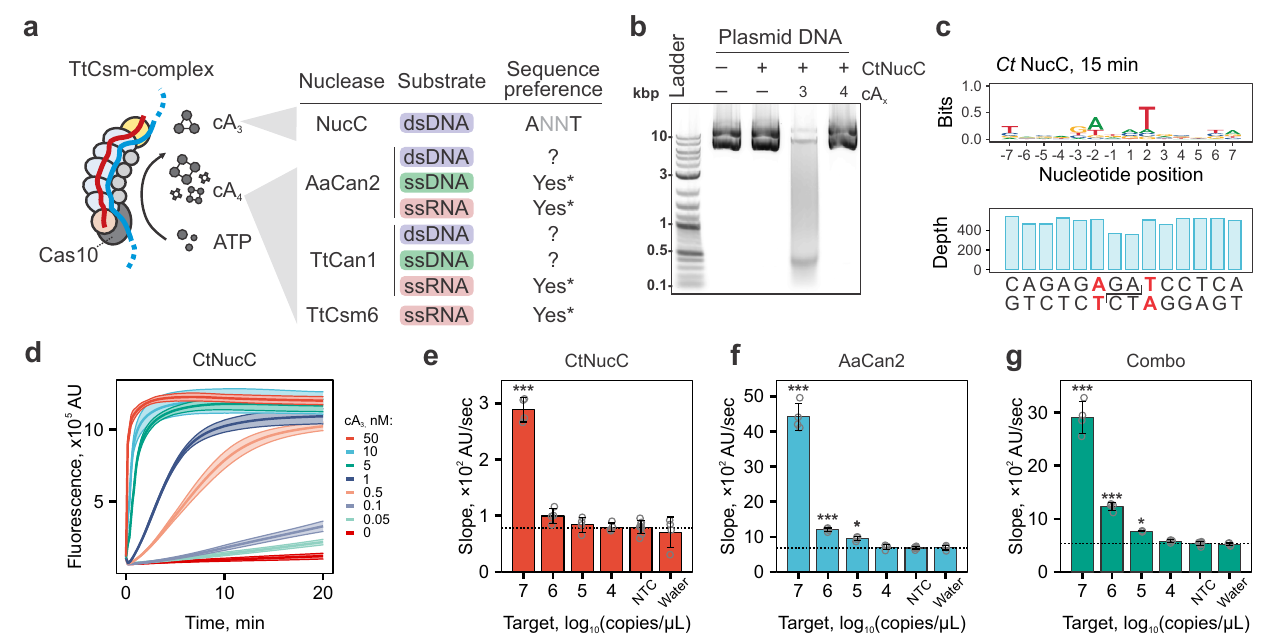
Fig.4|IncorporationofcA 3 -activatednucleasesintoCsm-basedRNAdetection assay. a The target bound TtCsm complex primarily generates cA 4 and cA 3 . Schematic summarizes cA 4 - and cA 3 -dependent activities of nucleases biochemi- cally tested. N/D – not detected; Asterisks (*) indicate nucleases that have sequencespreferences(SupplementaryFig.6). b CtNucC(15nM)isactivatedbycA 3 (20nM) and cleaves plasmid DNA into short fragments in 15min. c Deep sequen- cing of DNA fragments generated after 5min of incubation with CtNucC revealed the preferential cleavage sites (ANNT). The reduced sequencing depth at the cut